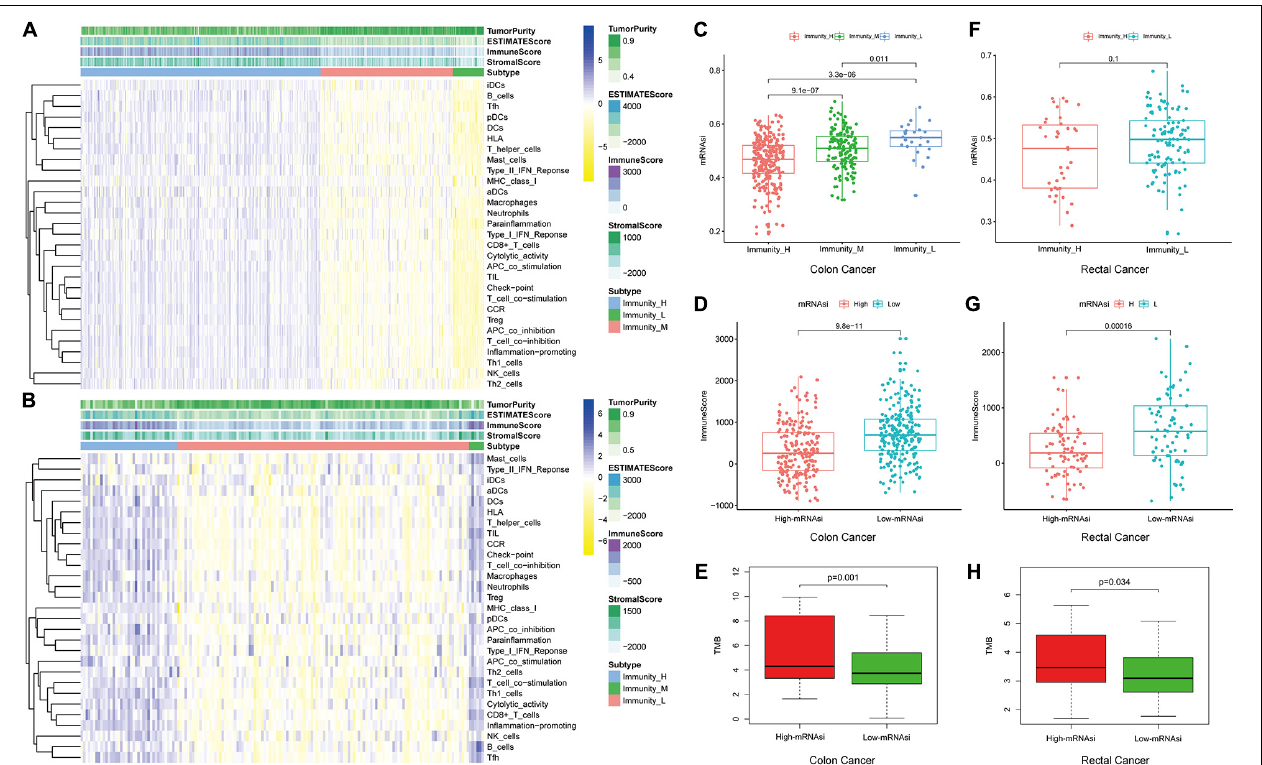
FIGURE 2 | Hierarchical clustering of colon and rectal cancer yields three stable subtypes in four different datasets named Immunity_H, Immunity_M, and Immunity_L. Tumor purity, stromal score, and immune score were evaluated by ESTIMATE. (A) The colon cancer patients in the TCGA-COAD database. (B) The rectal cancer patients in the TCGA-READ database. (C,F) Comparison of the mRNAsi levels between three colorectal cancer subtypes. Mann–Whitney U -test. (D,G) Comparison of the immune cell infiltration levels between different mRNAsi groups of colorectal cancer. Mann–Whitney U -test. (E,H) Comparison of the TMB levels between different mRNAsi groups of colorectal cancer. Kruskal–Wallis rank sum